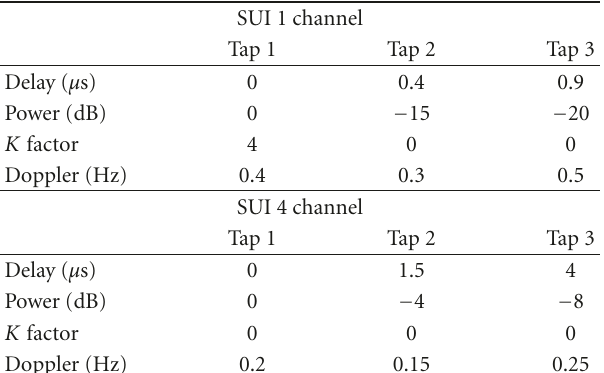
Table 1: SUI channel models.